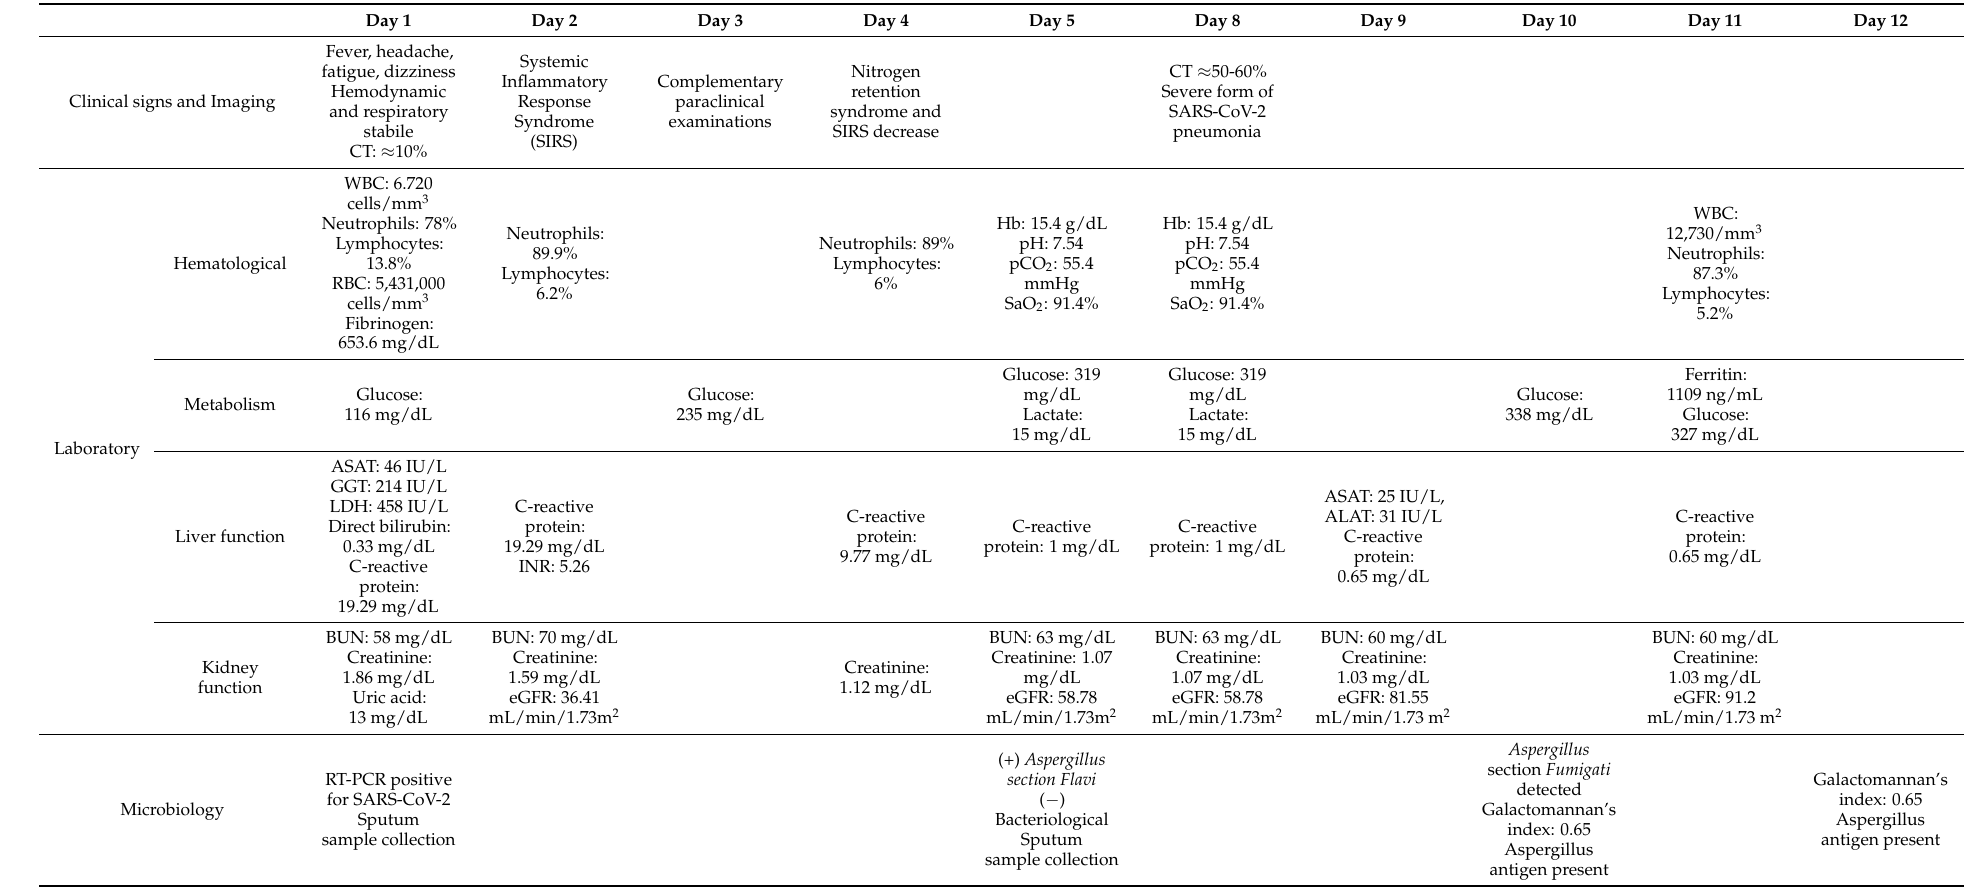
Table 2. Evolution of the laboratory tests and general presentation of the patient